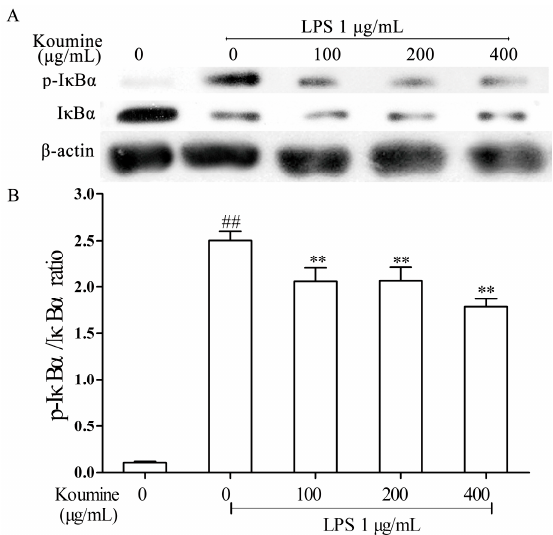
Figure 5. Effect of koumine on the expression of p-I κ B α and I κ B α in LPS stimulated-RAW264.7 cells. Cells were pretreated with 100, 200 or 400 µ g/mL koumine for 6 h. Subsequently, cells were treated with 1 µ g/mL LPS in the mediums containing koumine for 30 min. Equal amounts of protein in cell lysates were analyzed by Western blot. The β -actin protein levels were used to confirm that equal amounts of protein were subjected to electrophoresis. ( A ) The expression levels of p-I κ B α and I κ B α ; and ( B ) The quantification histogram of p-I κ B α protein expression normalized by β -actin. The data were expressed as mean ± standard deviations (SD) ( n = 3). ## p < 0.01 vs. control group; ** p < 0.01 vs. LPS group.